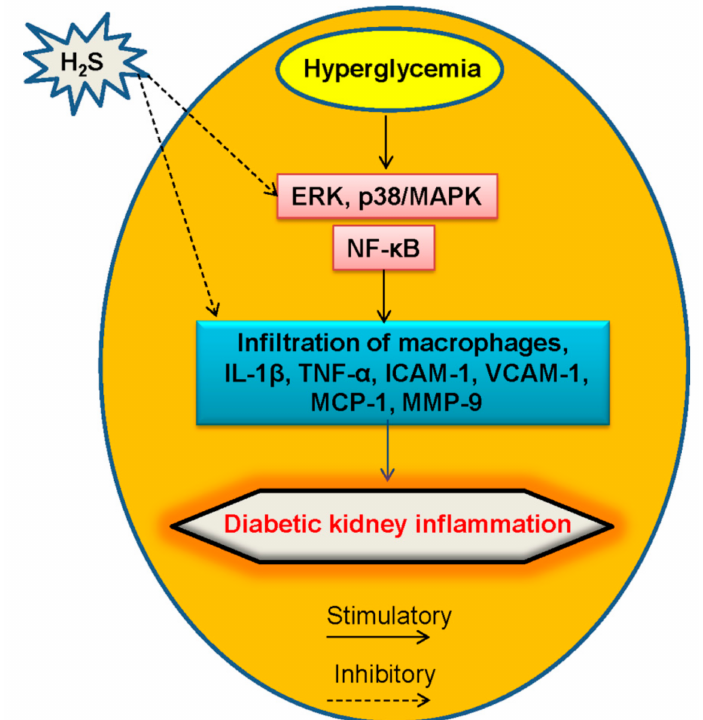
Figure 5. A proposed model of diabetic kidney inflammation mediated by H 2 S. The anti-inflammation mechanisms of H 2 S may involve its inhibition of macrophages infiltration, as well as its blockade of NF- κ B and MAPK signaling in renal system. NF- κ B, nuclear factor kappa-light-chain-enhancer of activated B cells; MAPK, mitogen-activated protein kinase, TNF- α , tumor necrosis factor α ; IL-1 β , interleukin-1 β ; VCAM-1, vascular cell adhesion molecule-1; ICAM-1, intercellular adhesion molecule-1; MCP-1, monocyte chemotactic protein-1; MMP-9, matrix